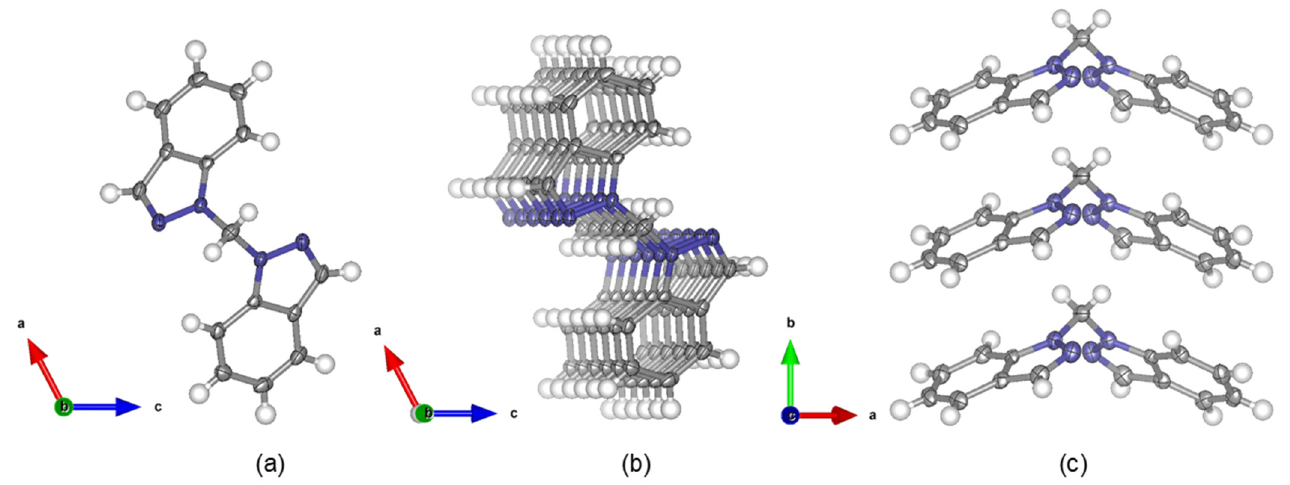
Figure 3. Crystal structure of bis(1 H -indazol-1-yl)methane, L 1 with thermal ellipsoids displayed at 50% probability ( a ) viewed down the b -axis. Extended packing viewed ( b ) with a 5° rotation about the crystallographic b -axis and ( c ) down the crystallographic c -axis.